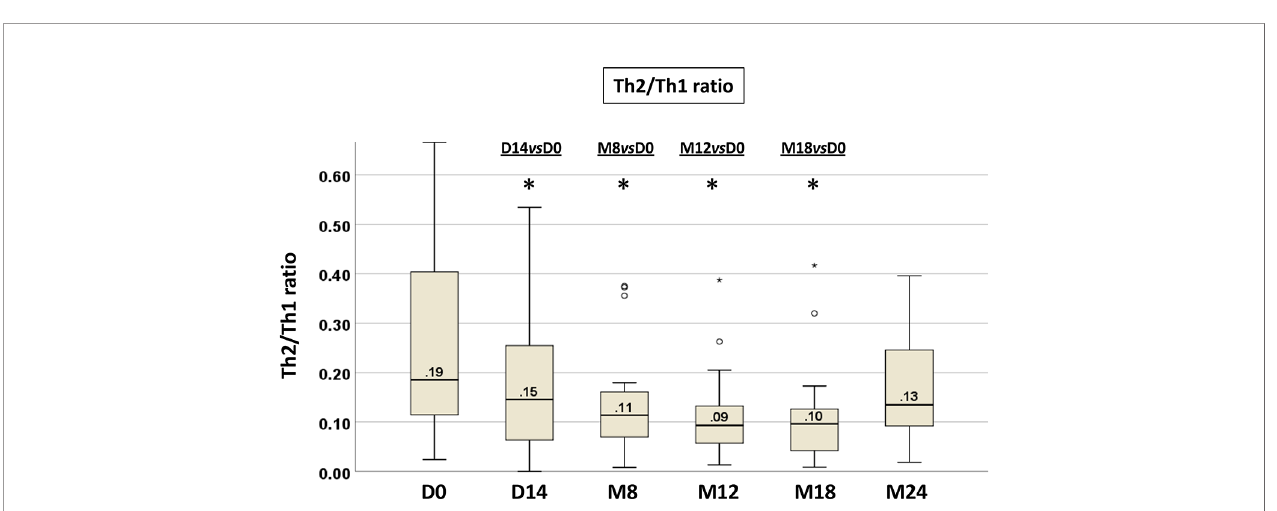
FIGURE 4 | Longitudinal analysis of the Th2/Th1 ratio from paired PB samples before and during ibrutinib treatment. The intra-individual variations in T-cell production of IL-4 and IFN g are expressed as Th2/Th1 ratio. Samples at D0, n=71; at D14, n=50; at M8, n=30; at M12, n=25; at M18, n=22; at M24, n=10 (Wilcoxon paired test D14 vs D0, M8 vs D0, M12 vs D0, M18 vs D0, M24 vs D0;